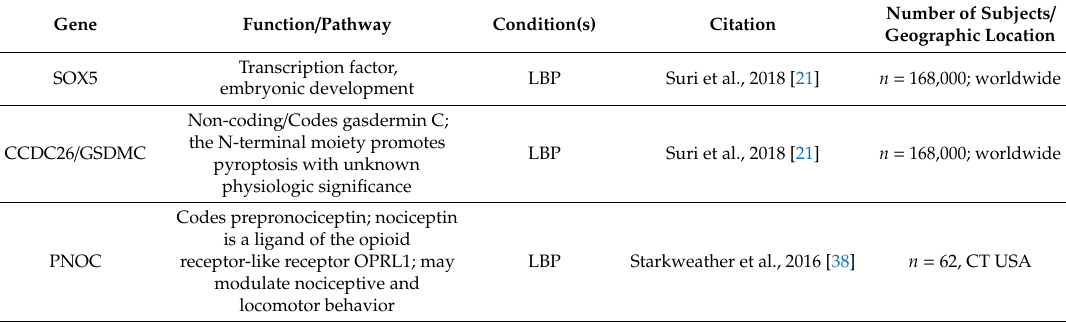
Table 4. Genes related to transcription factors, neurotransmission, and other unknown